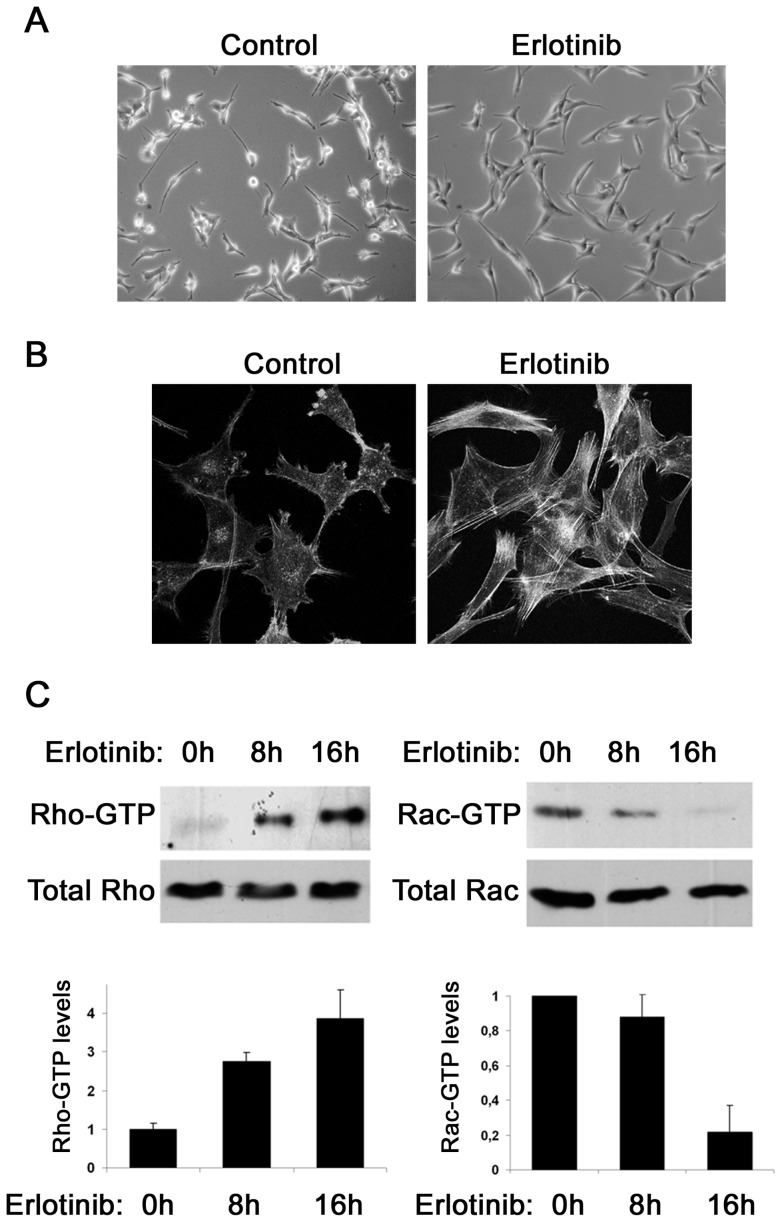
EGFR inhibition leads to actin cytoskeleton reorganization through Rho GTPase modulation.(A) Representative phase-contrast micrographs of U87MG cells left untreated (control) or treated for 24 h with 10 µM erlotinib (erlotinib). (B) U87MG cells grown on coverslips were left untreated (control) or were treated for 24 h with 10 µM erlotinib (erlotinib), fixed and stained with TRITC-labelled phalloidin. Bar, 5 µm. (C) U87MG cells were treated as indicated, harvested and RhoA and Rac1 activation were analyzed by GST-Rhotekin and GST-PBD pulldown, respectively, followed by western blotting with anti-RhoA and anti-Rac1 antibodies (upper panel). An aliquot of each lysate was also loaded in another gel to analyze total RhoA and total Rac1 levels (bottom panel). The graphs represent the quantified mean ± SD Rho/Rac activation values (Rho-GTP/Total Rho and Rac-GTP/Total Rac), relative to untreated cells, from three independent experiments.